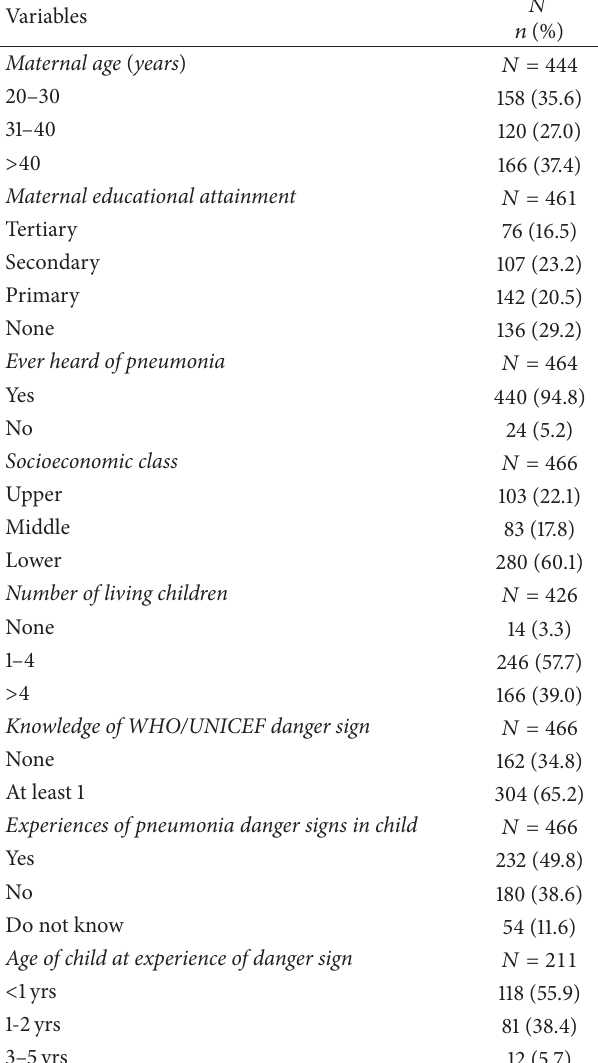
Table 1: Descriptive summary of study